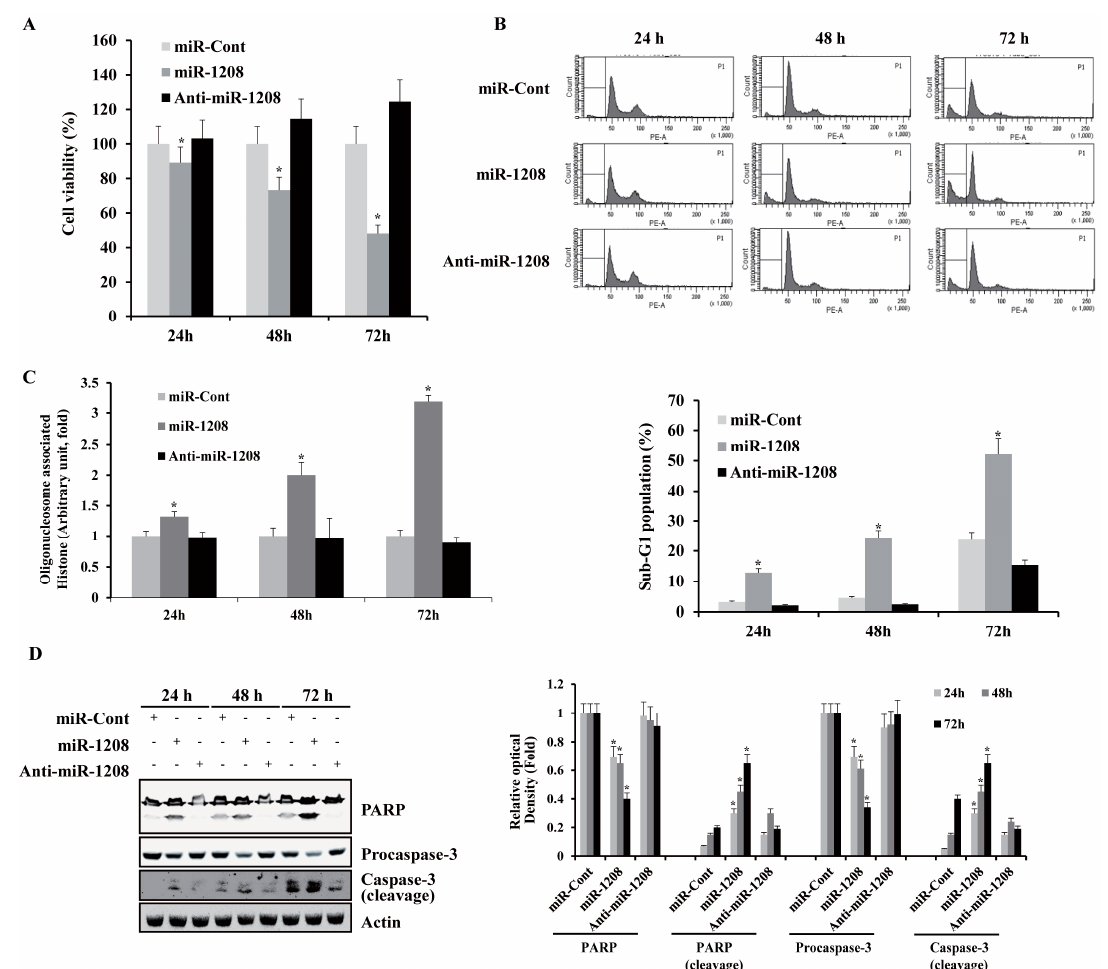
Figure 1. MiR-1208 inhibits renal cancer cell proliferation and promotes apoptosis. ( A ) Caki-1 cells were transfected with the indicated miRNAs for 24, 48, or 72 h and their cell viability was quantified using the MTT assay. The data are reported as the mean ± SD ( n = 3). * indicates significantly different from miR-Cont-transfected cells (p<0.05). ( B ) Caki-1 cells were transfected with miR-1208 or miR-Cont for 24, 48, or 72 h. FACS analysis was performed to measure a sub-G1 fraction. Histograms of flow cytometry are shown in the upper panel . Percentages of sub G1 populations are shown in bottom panel . Data are reported as the mean ± SD ( n = 3). * indicates significantly different from miR-Cont-transfected cells (p<0.05). ( C ) Nuclei and fragmented DNA were detected by a DNA fragmentation detection kit* indicates significantly different from miR-Cont-transfected cells (p<0.05). ( D ) Equal amounts of cell lysates (50 μ g) were subjected to electrophoresis and were immunoblotted for PARP and caspase-3 antibodies. Actin was used for normalization in all immunoblots. Using ImageJ software, the intensity of each protein in miRs-transfected cells were normalized to actin and expressed as a ratio of the densitometric value ( right panel ). * indicates significantly different from miR-Cont-transfected cells (p<0.05) at each time point.